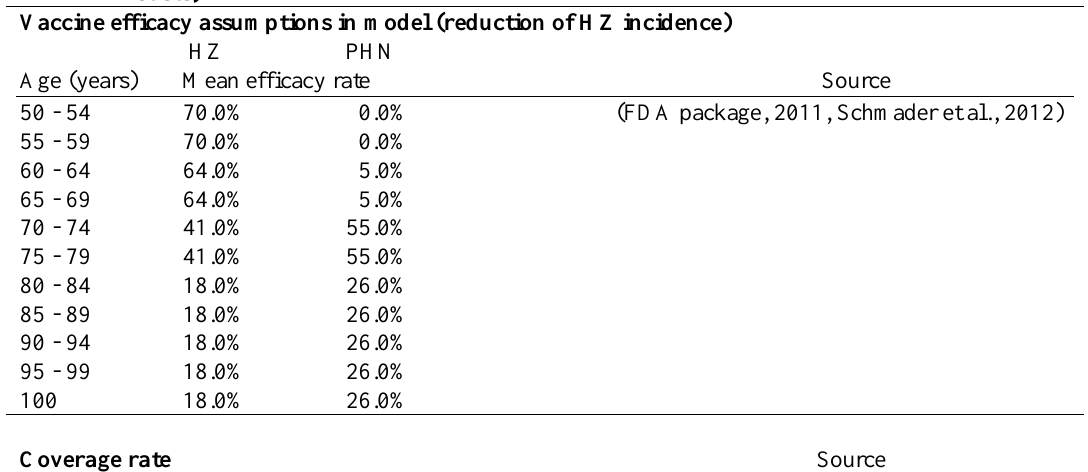
Base case assumptions (efficacy, coverage rate, utility values, vaccine